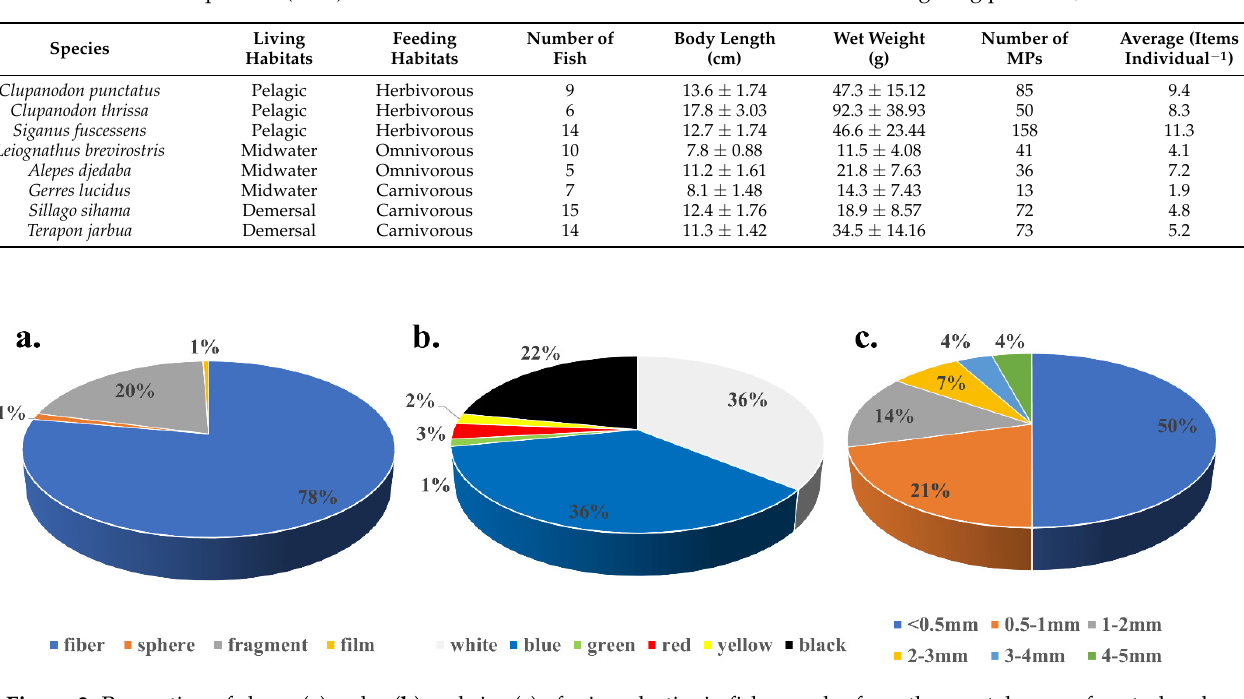
Figure 3. Proportion of shape ( a ), color ( b ) and size ( c ) of microplastics in fish samples from the coastal areas of central and western Guangdong province.